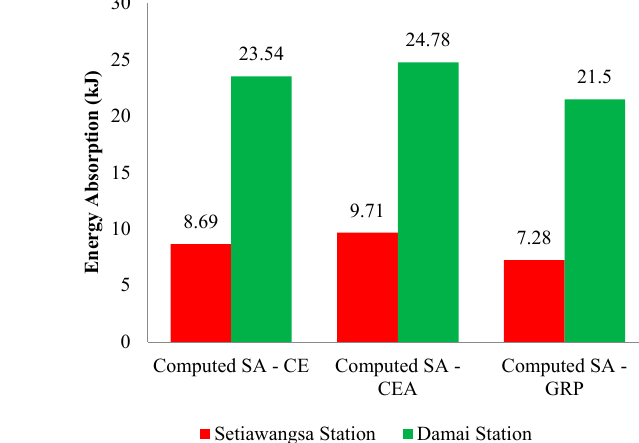
30 kA ( left ) and 90 kA ( right Figure 14. Comparison of the arrester thermal energy absorption between the computed bracket material cases for both